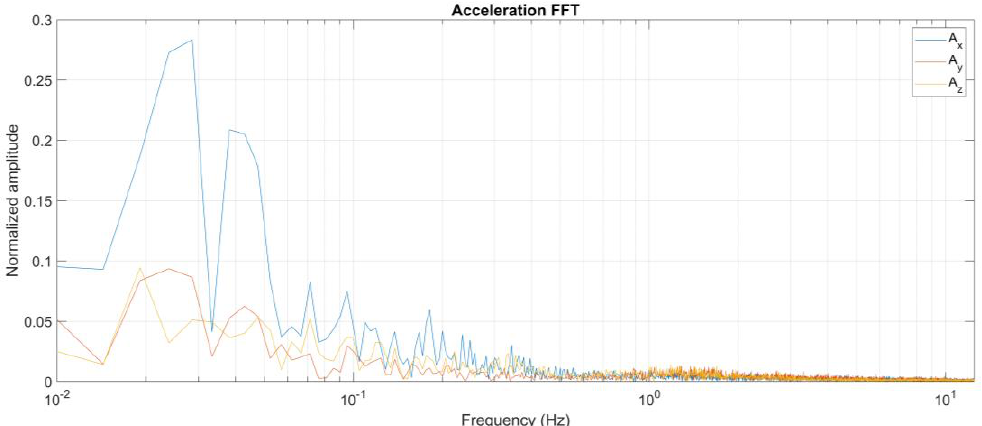
Figure 8. Frequency domain analysis of the acceleration signal on the tree axes (X, Y, Z) calculated by Fast Fourier Transform.